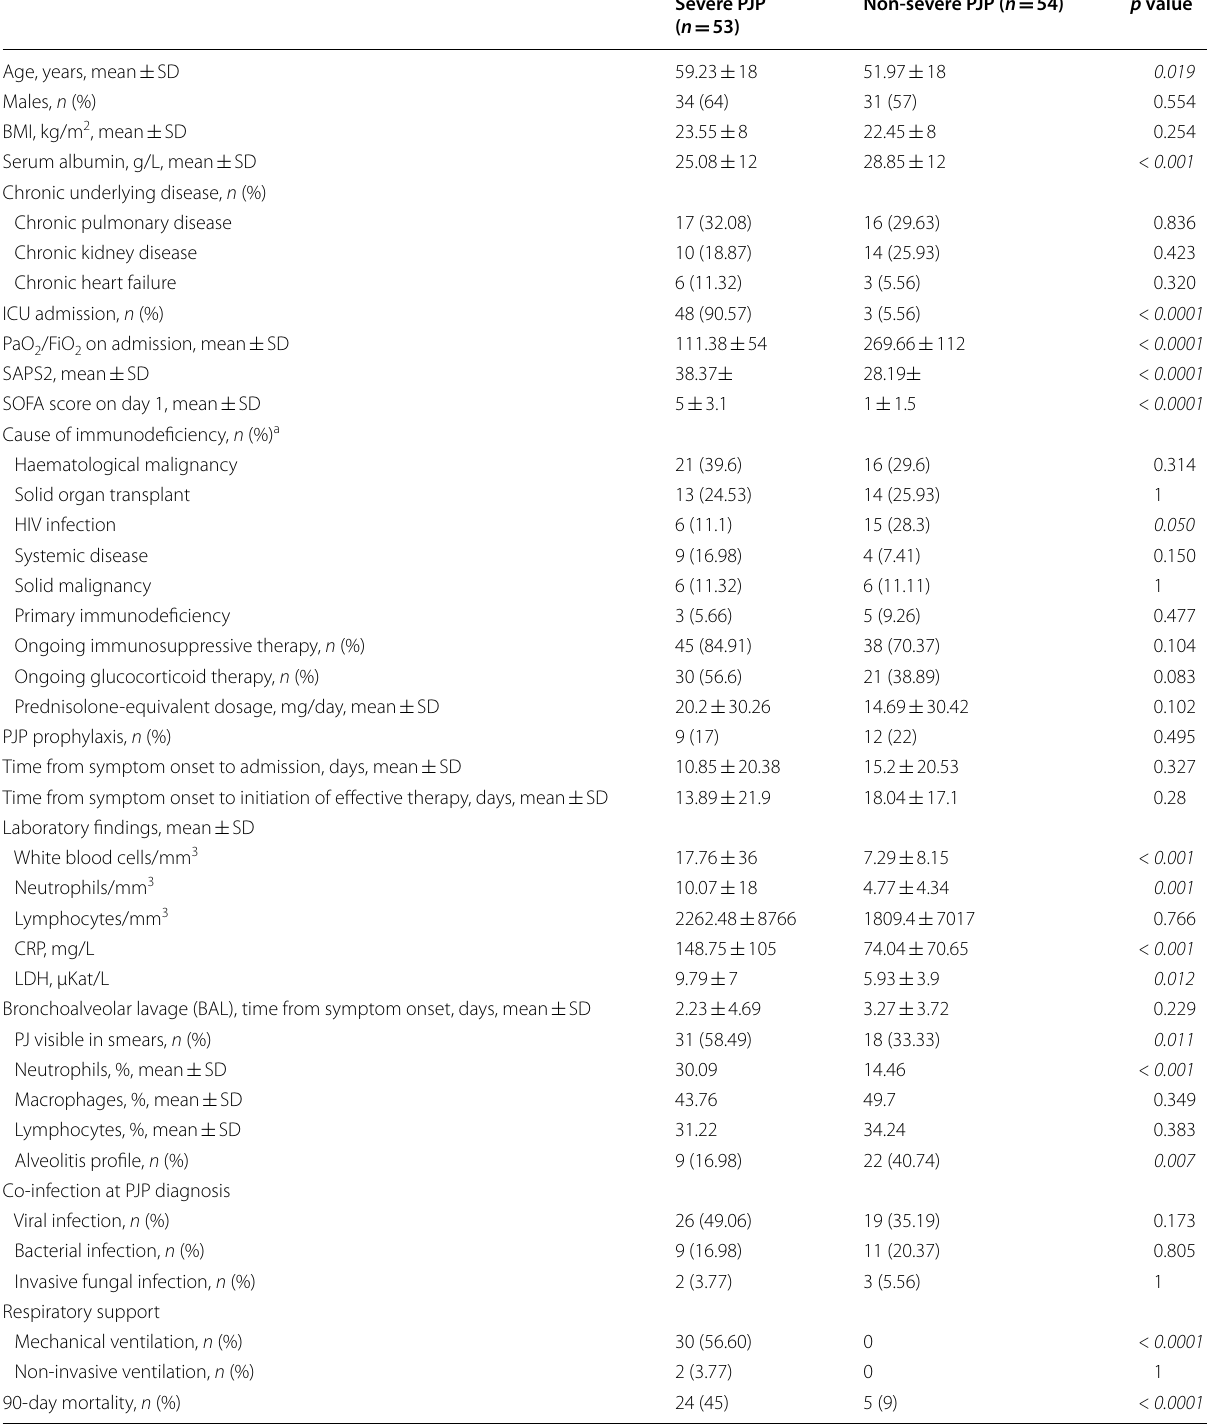
Table 2 Comparison of patients with severe and non-severe Pneumocystis jirovecii